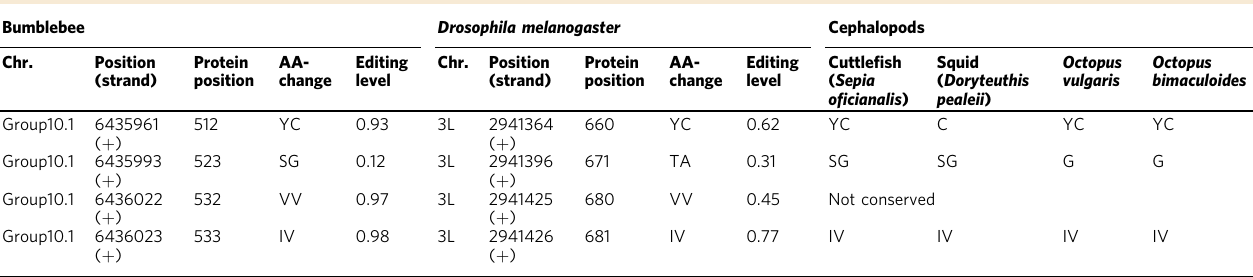
Table 2 Comparison of Shab editing in bumblebees, Drosophila, and Cephalopods Bumblebee Drosophila melanogaster